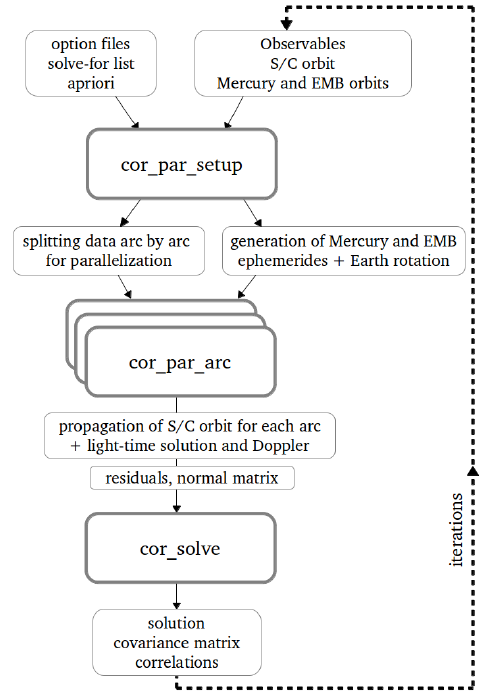
Figure 2. Block diagram of a differential corrector decomposed in three steps: (1) in “cor_par_setup” all the input options are read, data are split for the following parallel computation and the orbits of Mercury and EMB are propagated; (2) “cor_par_arc” contains most of the computationally expensive processing and is parallelized, by executing multiple copies of the same code, without need for interprocess communication; at this stage, the orbit of the spacecraft is propagated at each arc, the light-time computation is performed and residuals and normal matrix are given as output for the next step; (3) in “cor_solve” the covariance matrix and the LS solution are